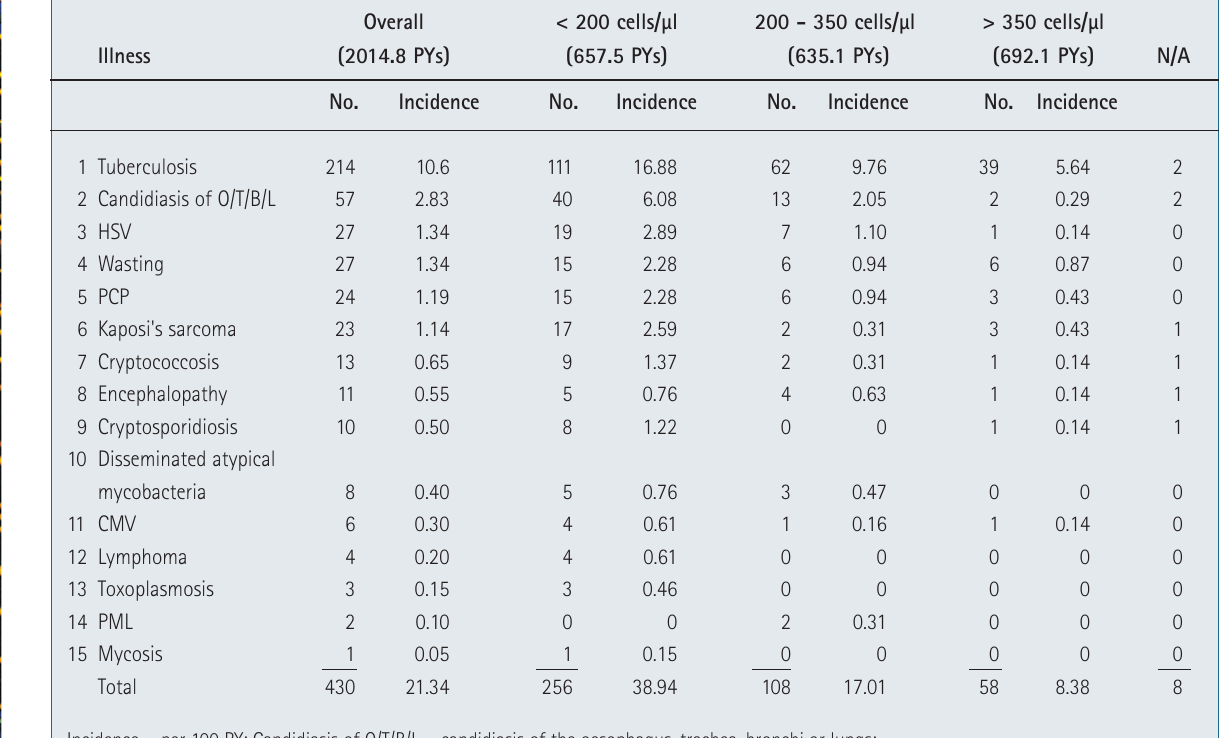
TABLE II. INCIDENCE OF AIDS-DEFINING ILLNESSES IN 1 215 HIV-INFECTED PATIENTS WITH NO ACCESS TO HAART